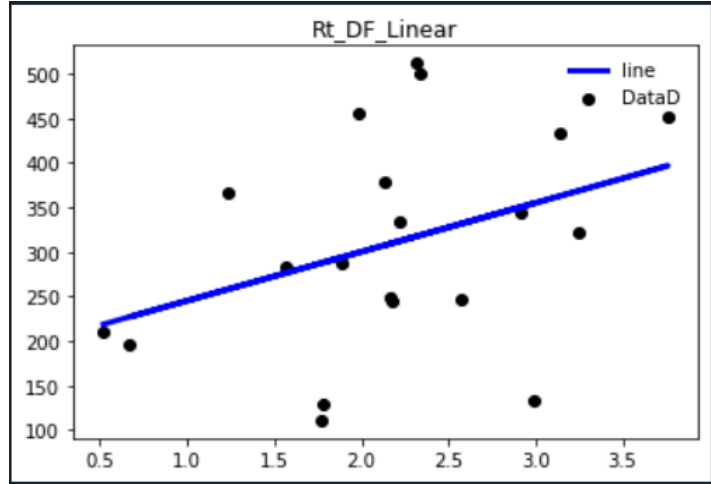
Figure 21. Schematic diagram of fitting 20 𝑅 𝑡 data diagram.